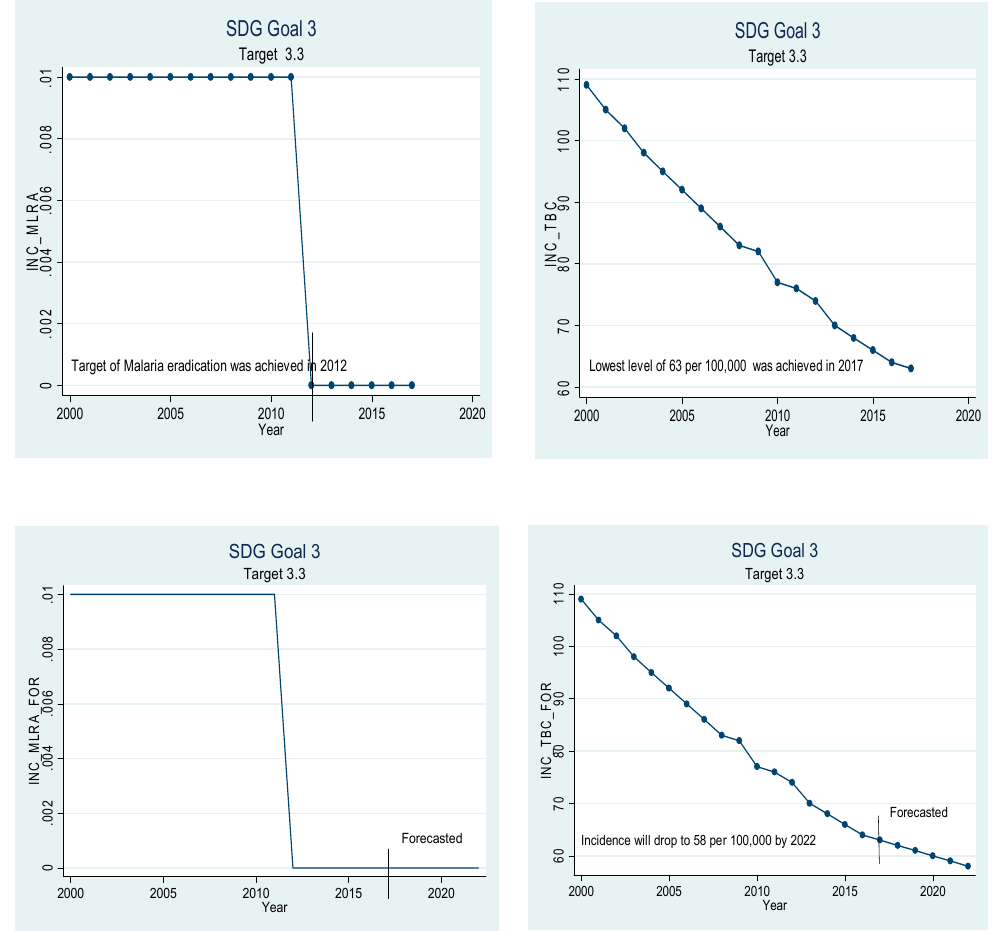
Figure 3. Sustainable development goal 3, target 3.3 (end of tuberculosis, malaria, etc.) ex-post and ex-ante .